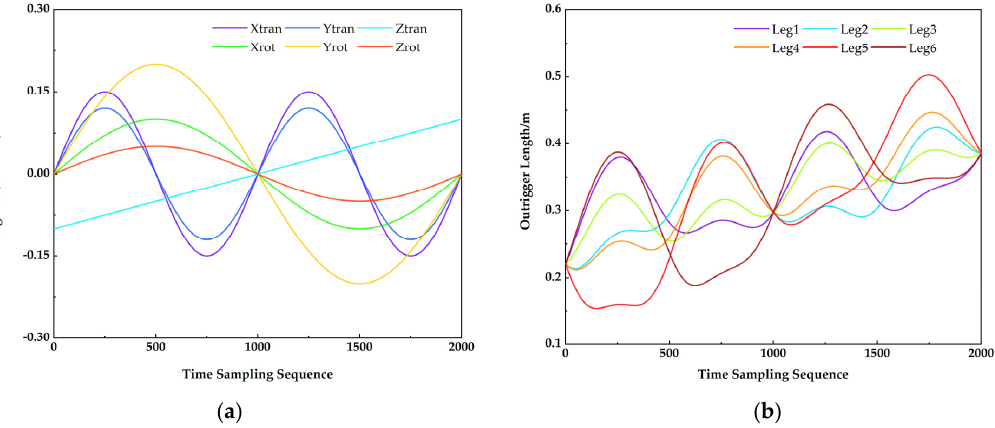
Figure 6. Continuous motion of the platform. ( a ) Motion of six degrees. ( b ) Length of six outriggers. Figure 7 shows the simulation results of PSO and SA–PSO algorithm, both of them